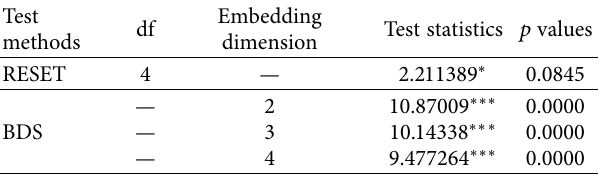
Table 7: Parameter estimation and test of the TVP regression model.